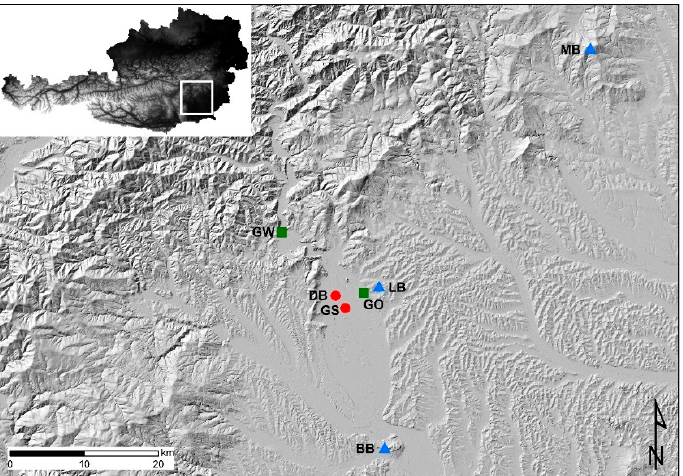
Figure 1. Location of the air quality monitoring stations selected for this study as listed in Table 1. Stations of investigation (Graz Don Bosco, DB, and Graz Süd, GS) are marked by red dots. Potential background stations, mandatory for the determination of the net dust load as proposed by the European Commission, are marked with blue triangles. Stations were filter samples for validation purposes were taken are marked via green squares.